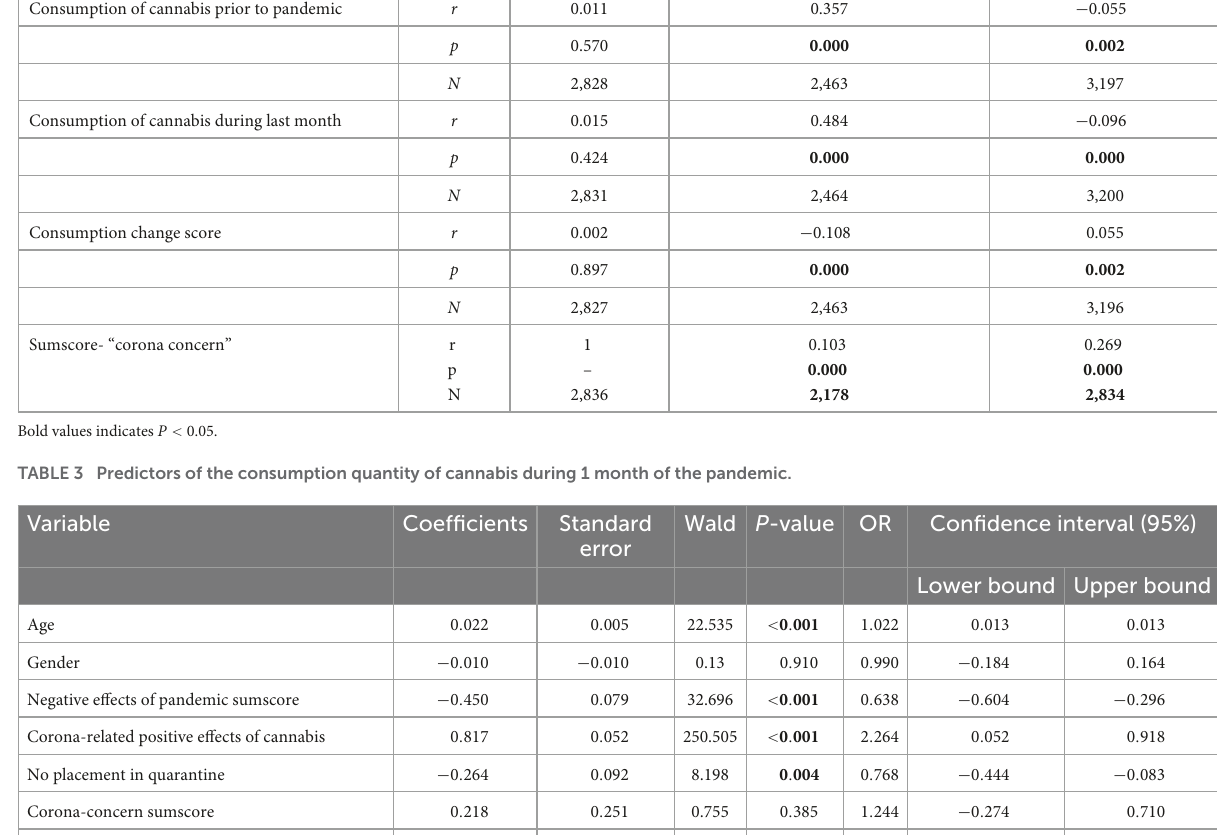
Corona Positive effects of cannabis Negative effects of concern during pandemic pandemic